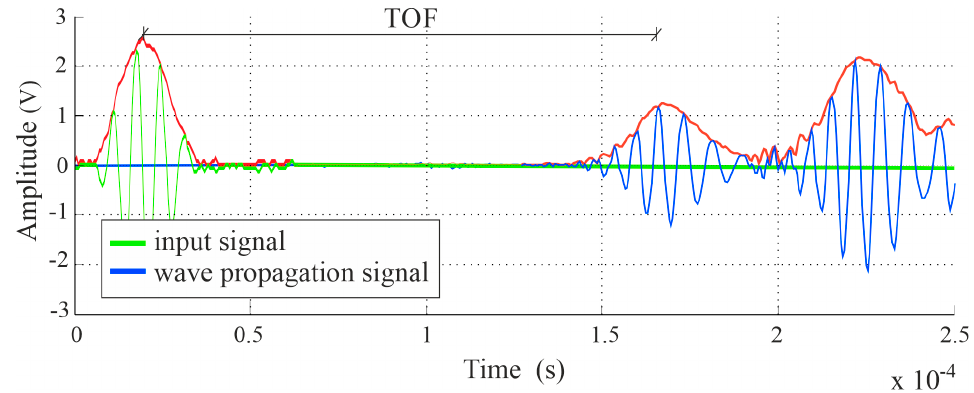
Figure 8. Determination of the time of flight (TOF) between transmitters and receivers.